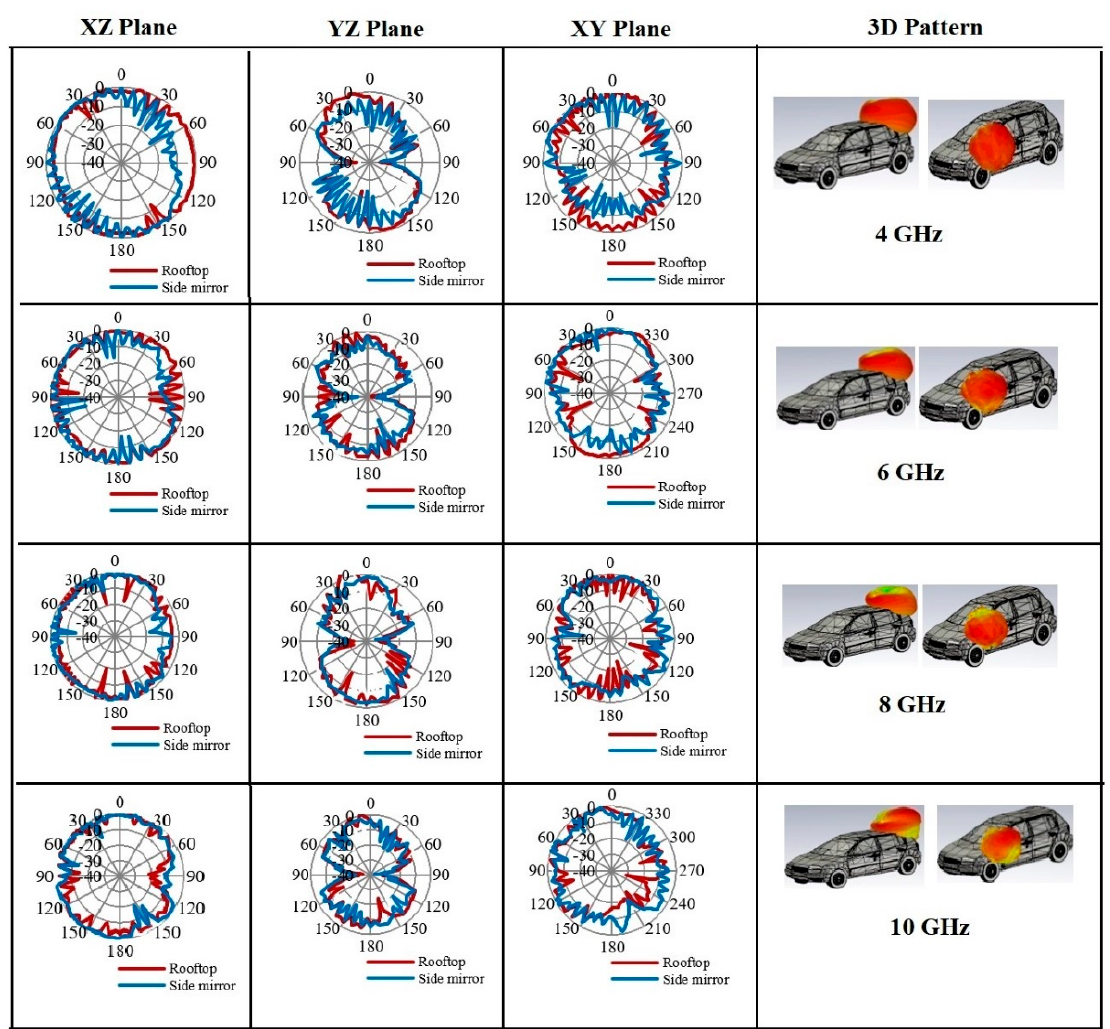
Figure 13. Far-field patterns in different positions on a car.